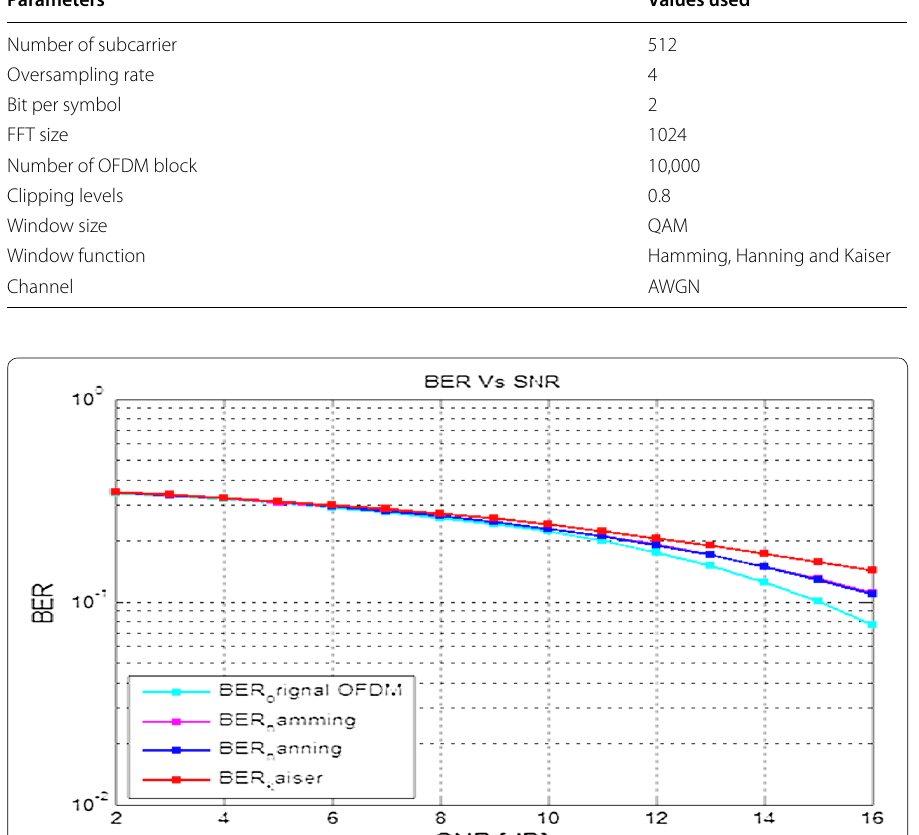
Table 4 Parameters considered for BER Parameters